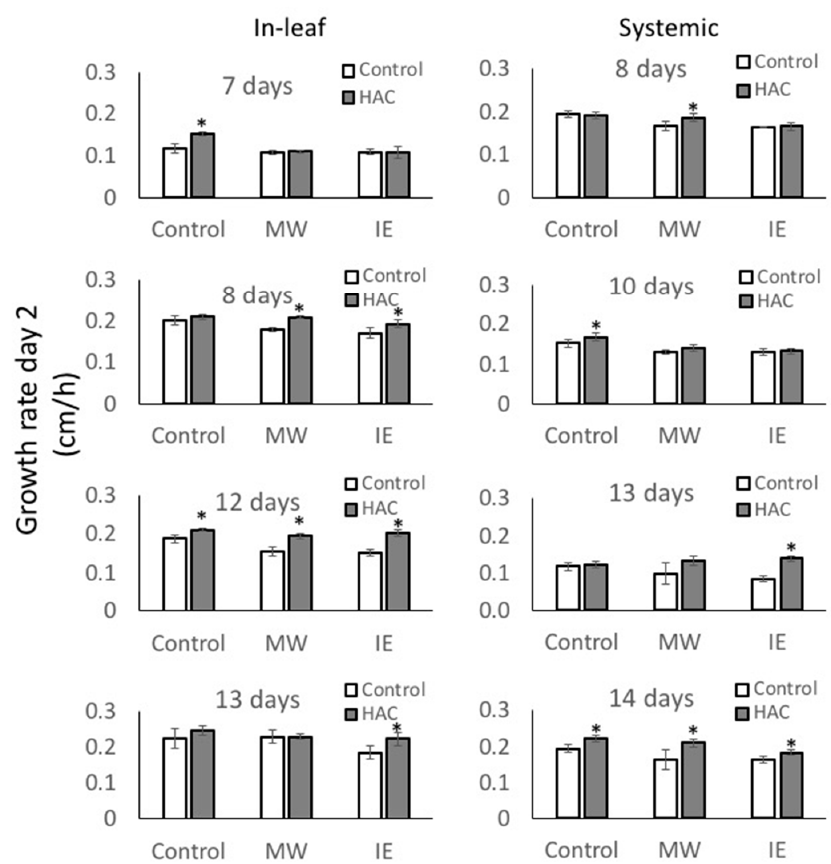
Figure 4 . The growth response of ( Z )-3-hexen-1-yl acetate-treated (Z-3-HAC) and untreated maize ( Zea mays ) seedlings ( n ≥ 7) after MW and IE treatment on day 2. Seedlings were first exposed to physiological concentrations of Z-3-HAC (2 μ g l − 1 air volume) for 16 h before being treated with MW or IE as described above. Growth rate (cm*h − 1 ) is shown for day 2 and is calculated as cm h -1 . Values are means ± SE and asterisks indicate significant differences between treated and untreated seedlings ( t test, P < 0.05).